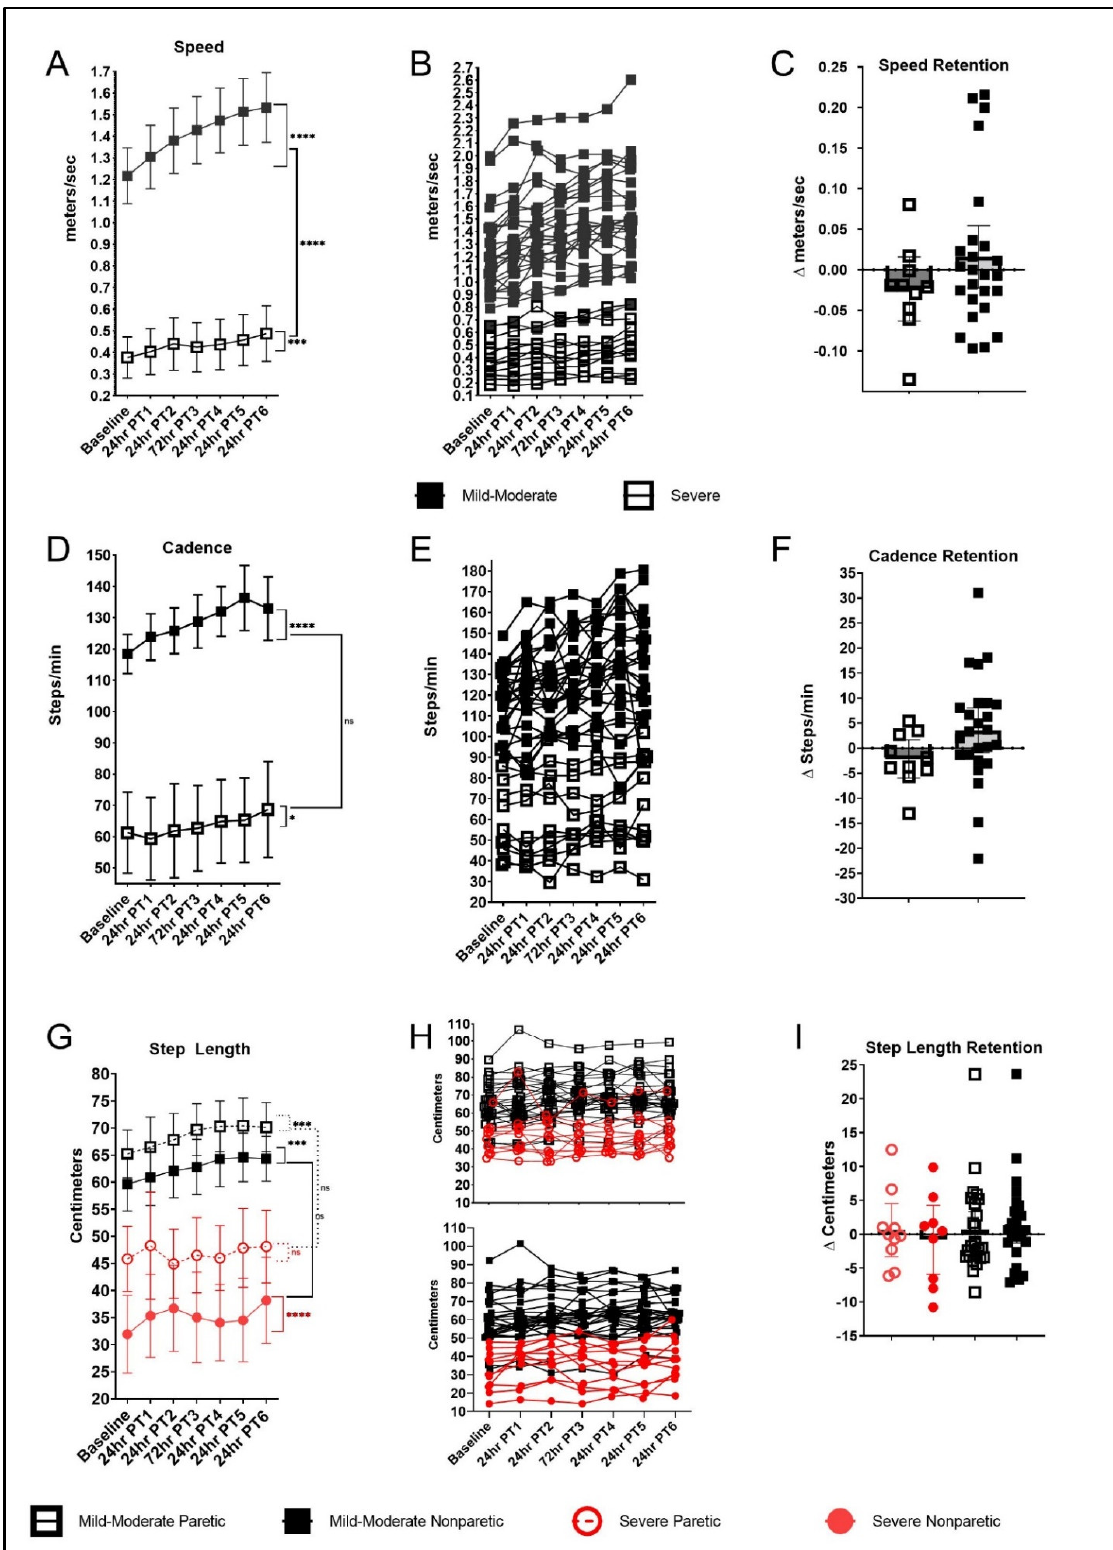
Figure 3. Overground walking performance (speed, cadence, step length). Mean progression in 10-mWT ( fast ) speed ( A ), individual values ( B ) and retention ( C ); cadence ( D ), individual values ( E ), and retention ( F ); paretic and nonparetic step lengths ( G ), individual values ( H ), and retention ( I ). Error bars show 95% CI; * p < 0.05; *** p < 0.001; **** p <